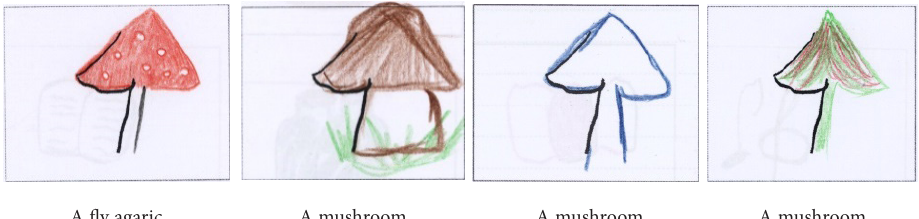
Figure 20. The creative task: interpretation of Fragment 3 – plants: mushrooms (source: testingmom.com, 2020)